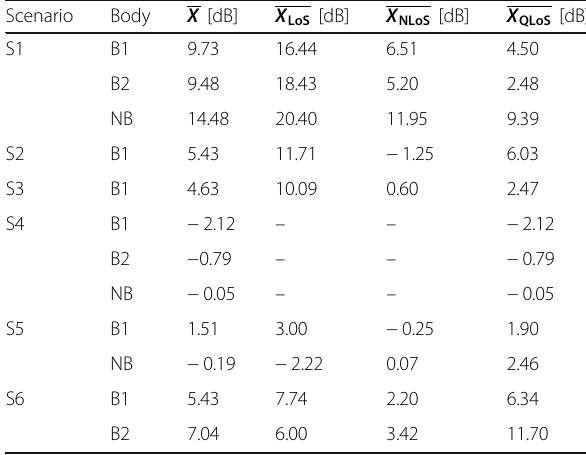
Table 3 Mean XPD for different propagation conditions and the total average for each scenario Scenario